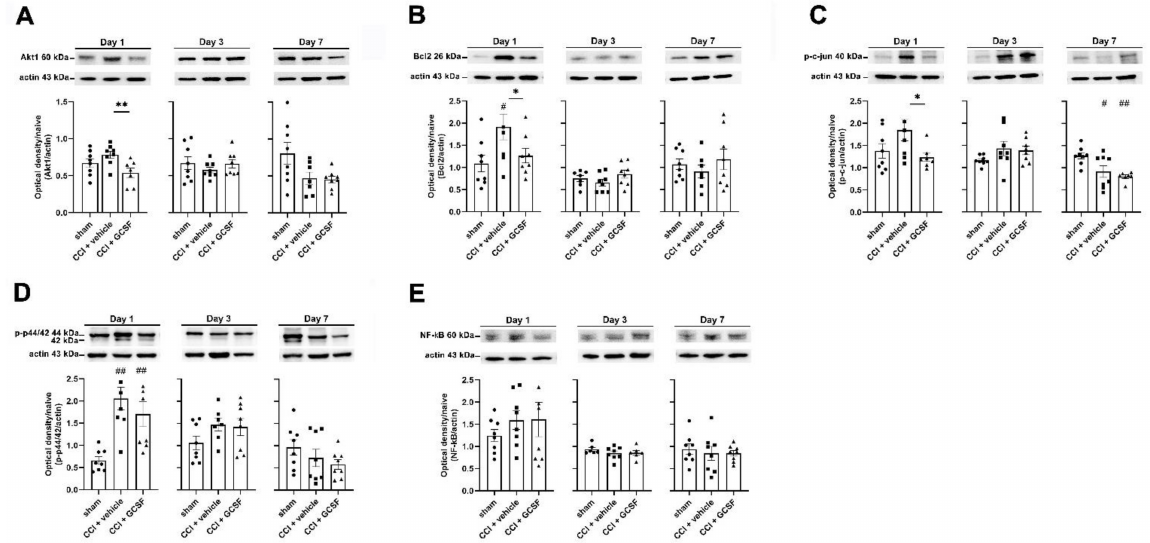
Figure 2. G-CSF downregulated Akt1, Bcl-2, and phospho-c-Jun protein levels in the injured sciatic nerve on the 1st day after nerve injury. However, G-CSF did not alter NF- κ B and phospho-p44/42 protein expression in the injured sciatic nerve from the 1st day to the 7th day after nerve injury. Statistical analyses of those proteins (Akt1, Bcl-2, phospho-c-Jun, phospho-p44/p42, NF- κ B) were analyzed by the data from micro-Western array in the NHRI, then we verified the protein expressions by the traditional representative Western blot bands in our laboratory. ( A ) Western blot analysis revealed significantly lower Akt1 protein levels (an upstream regulator of autophagy) in the injured sciatic nerve in G-CSF-treated CCI rats than in vehicle-treated CCI rats (** p < 0.01: G-CSF-treated CCI rats compared to vehicle-treated CCI rats) on the 1st day after nerve injury. However, there was no significant difference between vehicle-treated CCI rats and sham control rats. The data are shown as the means ± SEM. n = 8 in each group. ( B ) Western blot analysis revealed significantly higher Bcl-2 levels in the injured sciatic nerve in vehicle-treated CCI rats than in sham control rats ( # p < 0.05: vehicle-treated group compared to sham control rats) on the 1st day after nerve injury. In contrast, significantly lower Bcl-2 levels were observed in the injured sciatic nerve in G-CSF-treated CCI rats than in vehicle-treated CCI rats on the 1st day after nerve injury (* p < 0.05: G-CSF-treated CCI rats compared to vehicle-treated CCI rats). The data are shown as the means ± SEM. n = 8 in each group. ( C ) Western blot analysis revealed significantly lower phospho-c-Jun protein levels (an upstream regulator of autophagy) in the injured sciatic nerve in G-CSF-treated CCI rats than in vehicle-treated CCI rats (* p < 0.05: G-CSF-treated CCI rats compared to vehicle-treated CCI rats) on the 1st day after nerve injury. However, there was no significant difference between vehicle-treated CCI rats and sham control rats on the 1st day after nerve injury. Vehicle- and G-CSF-treated CCI rats had significantly lower phospho-c-Jun protein levels in the injured nerve than sham control rats ( # p < 0.05, ## p < 0.01: vehicle-treated CCI rats and G-CSF-treated CCI rats compared to sham controls) on the 7nd day after nerve injury. However, there was no significant difference between vehicle-treated rats and G-CFS-treated CCI rats. The data are shown as the means ± SEM. n = 8 in each group. ( D ) Vehicle- and G-CSF-treated CCI rats had significantly higher phospho-p44/42 protein levels in the injured nerve than sham control rats ( # p < 0.05, ## p < 0.01: vehicle-treated CCI rats and G-CSF-treated CCI rats compared to sham controls) on the 1st day after nerve injury. Phospho-p44/42 protein levels were lower in the injured nerve in G-CSF-treated CCI rats than in vehicle-treated CCI rats on the 7th day after nerve injury; however, the difference was not statistically significant. The data are shown as the means ± SEM. n = 8 in each group. ( E ) Western blot analysis did not reveal significant changes in NF- κ B protein expression in the injured nerve in sham control rats, vehicle-treated CCI rats, and G-CSF-treated CCI rats at different time points. The data are shown as the means ± SEM. n = 8 in each